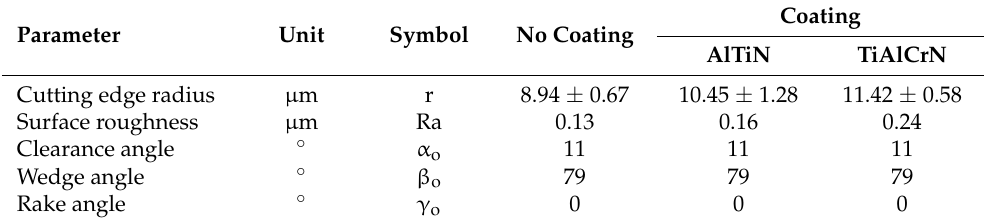
Table 1. Measured cutting tool geometry values.